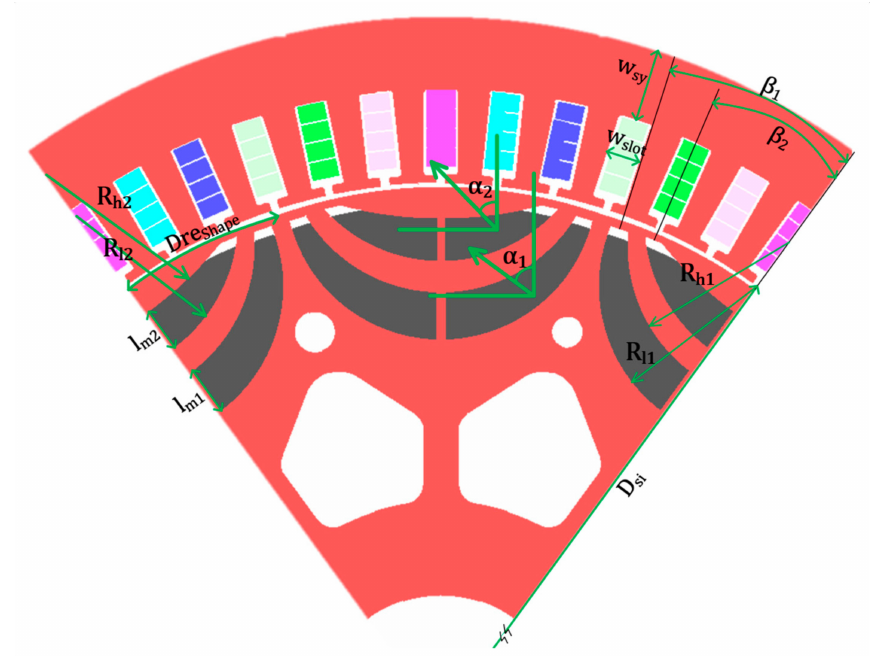
Figure 4. Baseline motor electromagnetic model and parameters.